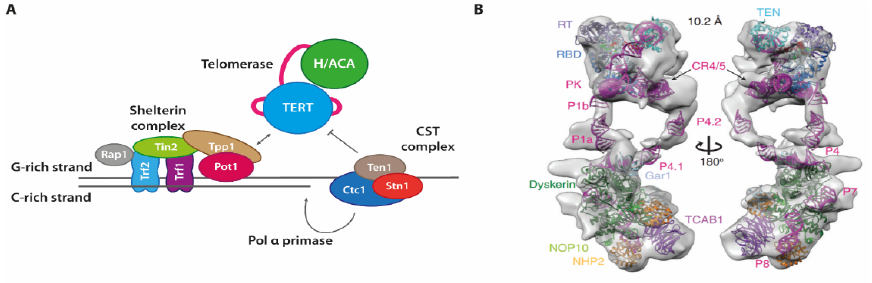
Figure 6. ( A ) Protein and RNP complexes at the chromosome ends. Whereas the shelterin complex binds to protect the chromosome ends, telomerase as well as the CST complex act on the G-rich or C-rich strand, respectively, to facilitate their synthesis. ( B ) Cryo-EM-based model structure of the human telomerase holoenzyme, taken from [63]. Copyright of Figure 6B by Wang et al. is with